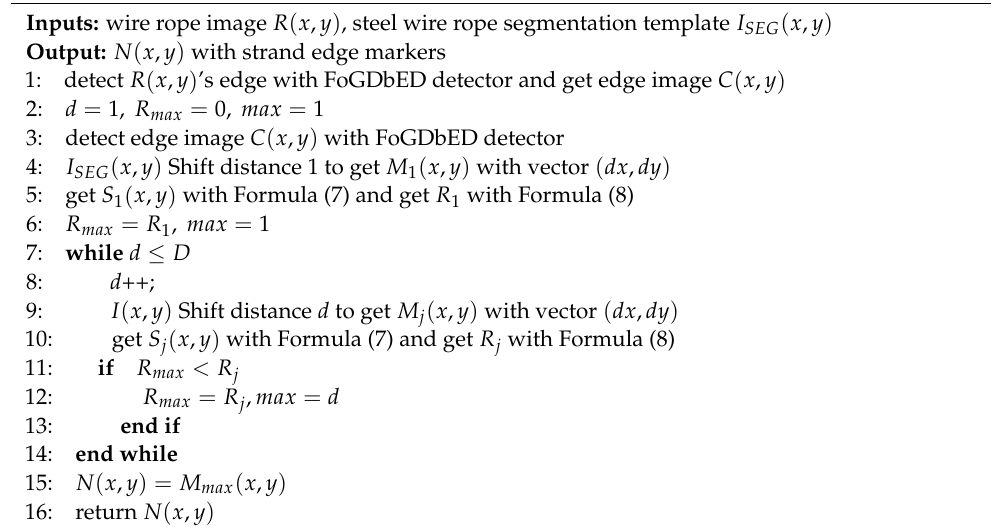
Algorithm 1. Rope-strand segmentation and correction method based on steel wire rope segmentation template.